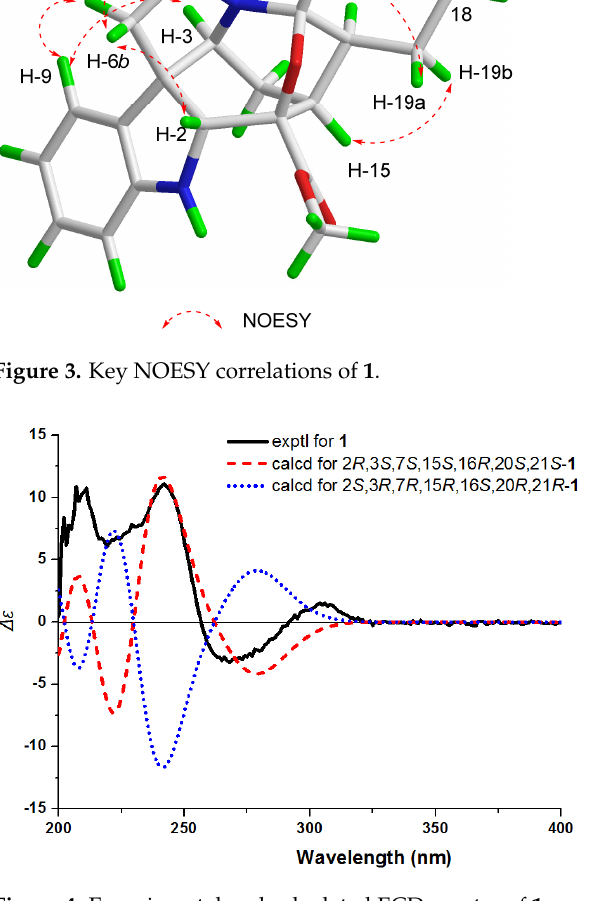
Figure 4. Experimental and calculated ECD spectra of 1 .